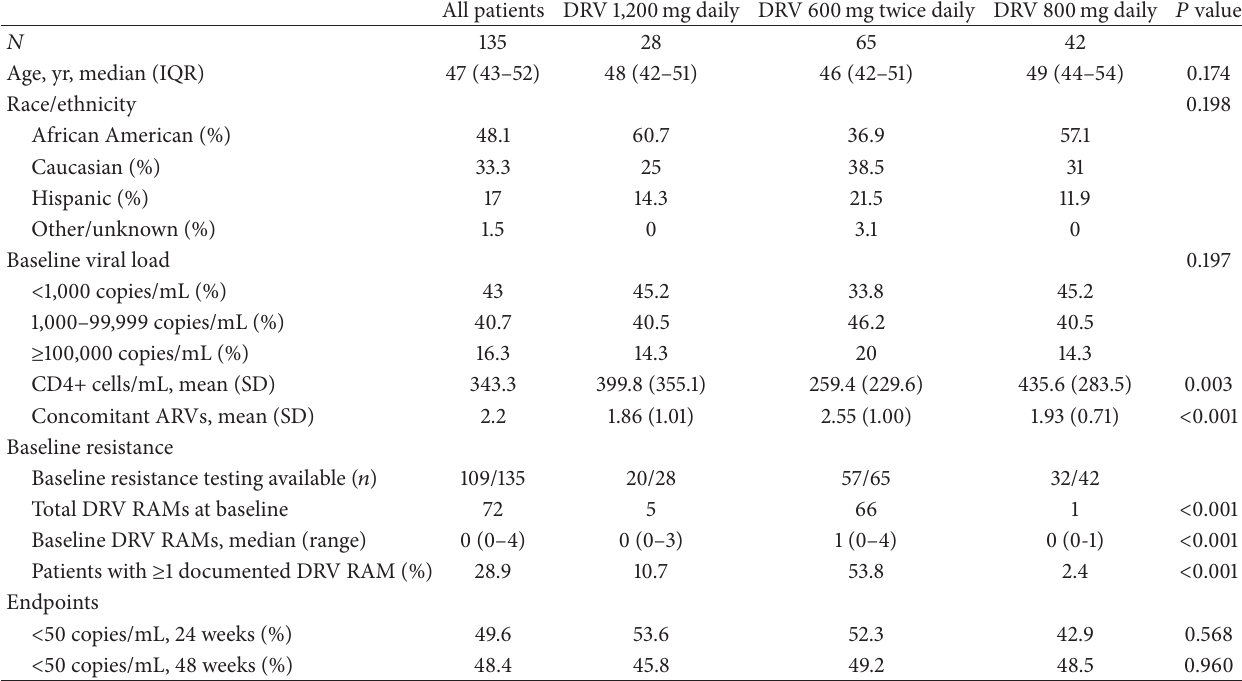
Table 1: Baseline characteristics and rate of viral suppression by darunavir